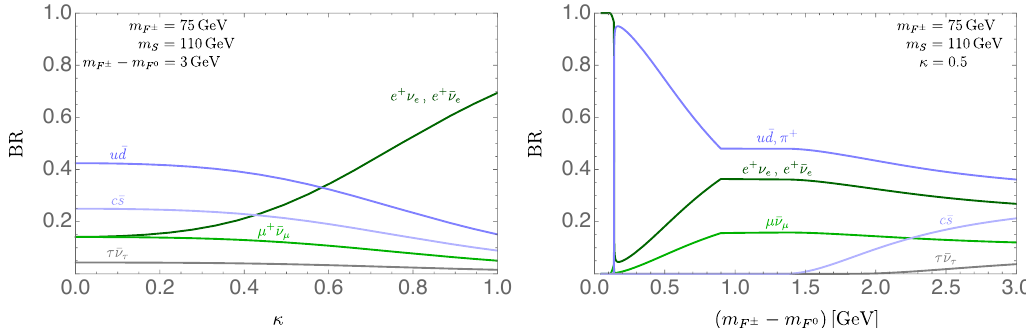
Figure 8 . Charged fermion F (cid:6) decay branching fractions as a function of the coupling (cid:20) for a mass splitting of m (cid:0) m = 3 GeV (left), and as a function of the mass splitting for coupling F 0 F (cid:6) (cid:20) = 0 : 5 (right). In both cases, the charged fermion mass is m = 75 GeV and the scalar singlet F (cid:6) mass is m S = 110 GeV. Decays into the charged pion are matched to decays into up and down quarks at (cid:1) m = 0 : 9 GeV. Decay widths are obtained from [63, 73]. UV